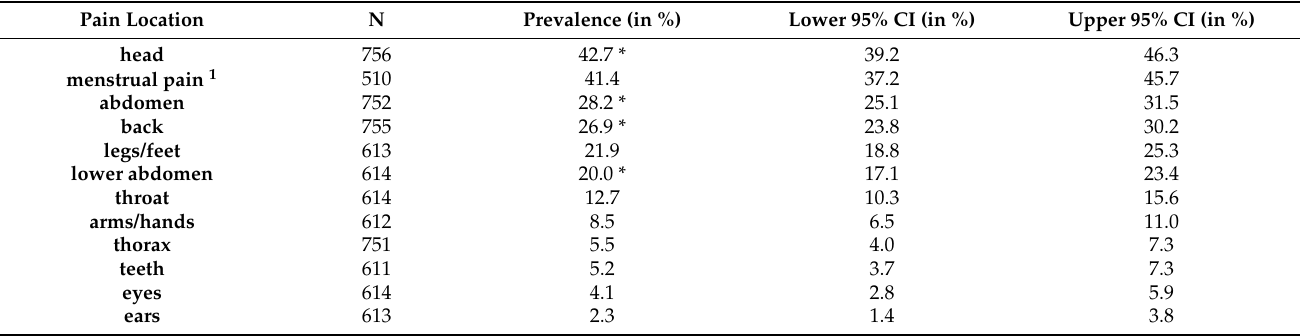
Table 1. Prevalence and 95% CI of recurrent pain in girls.